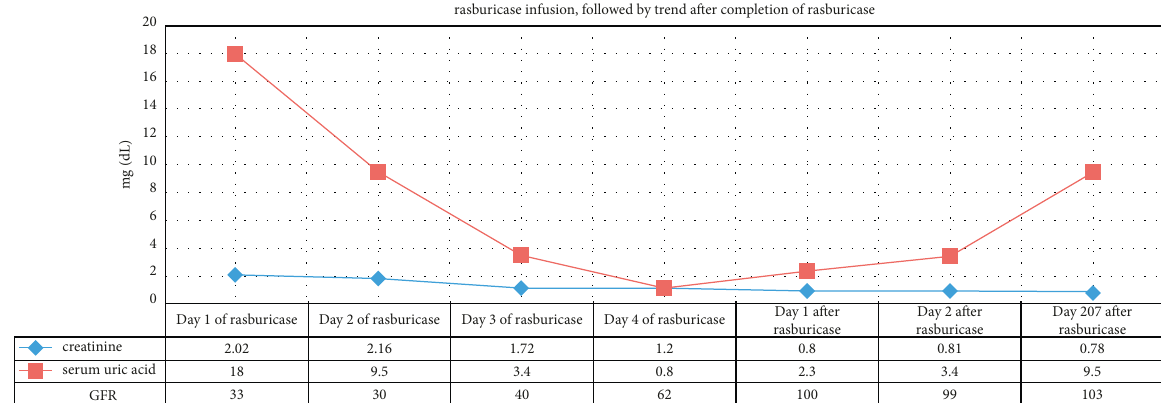
Figure 2: Serum creatinine, estimated glomerular filtration rate (GFR), and serum uric acid during and after rasburicase